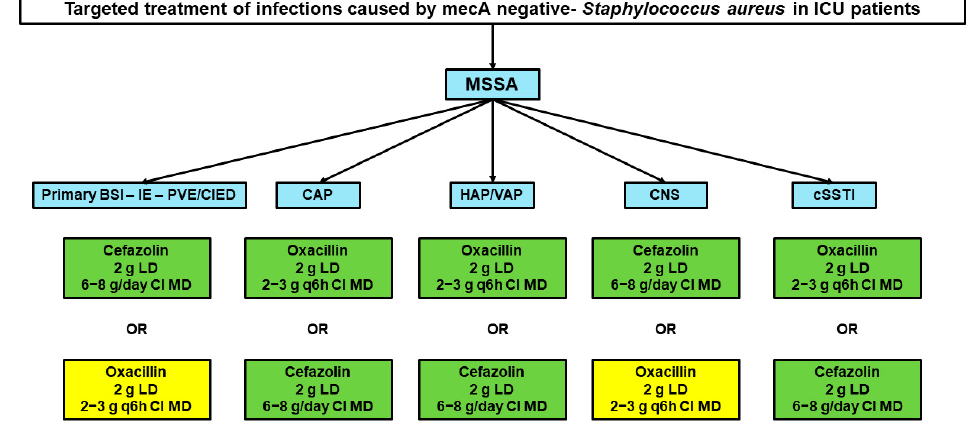
Figure 1. Algorithms for targeted therapy of infections caused by methicillin-susceptible Staphy- lococcus aureus . Green box: best therapeutic regimen according to current evidence; yellow box: alternative therapeutic regimen according to current evidence. BSI: bloodstream infection; CAP: community-acquired pneumonia; CI: continuous infusion; CIED: cardiac implantable electronic device infections; CNS: central nervous system; cSSTI: complicated skin and soft tissue infection; HAP: hospital-acquired pneumonia; ICU: intensive care unit; IE: infective endocarditis; LD: loading dose; MD: maintenance dose; PVE: prosthetic valve endocarditis; VAP: ventilator-associated pneumonia.